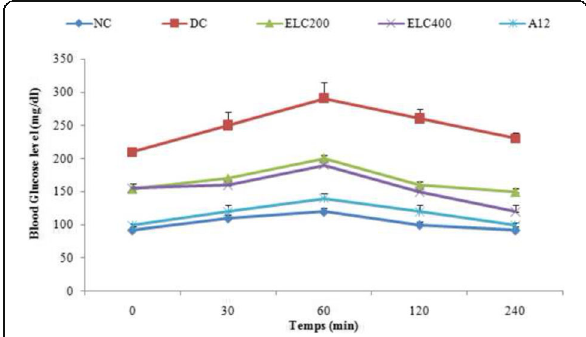
Fig. 3 Oral glucose tolerance levels in experimental groups of rats. Normal (NC) and Diabetic control (DC). ELC200&400: Ethanol extract from leaves of C. scolymus at doses of 200 and 400 mg/kg per day; A12: Acarbose at dose of 12 mg/kg per day for 28 days. Values are given as means ± SD ( n = 8 for each